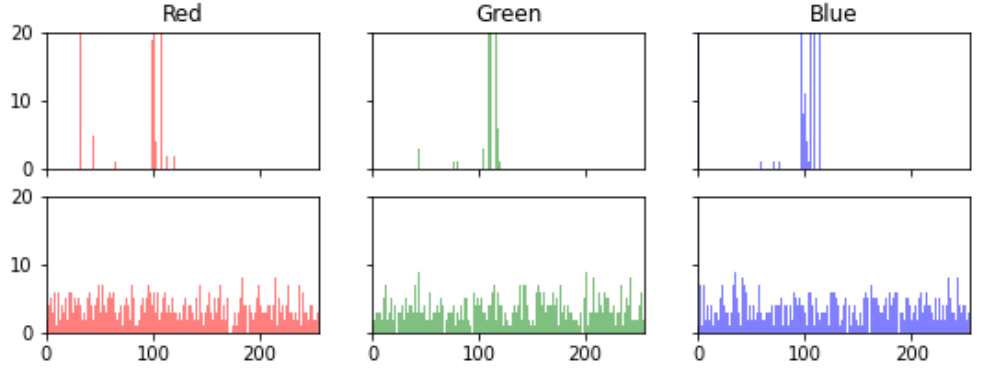
Figure 7. Histogram of the R, G, and B components of the pixels of the image version of Test File 1 (top row) and its cipher-image (bottom row).